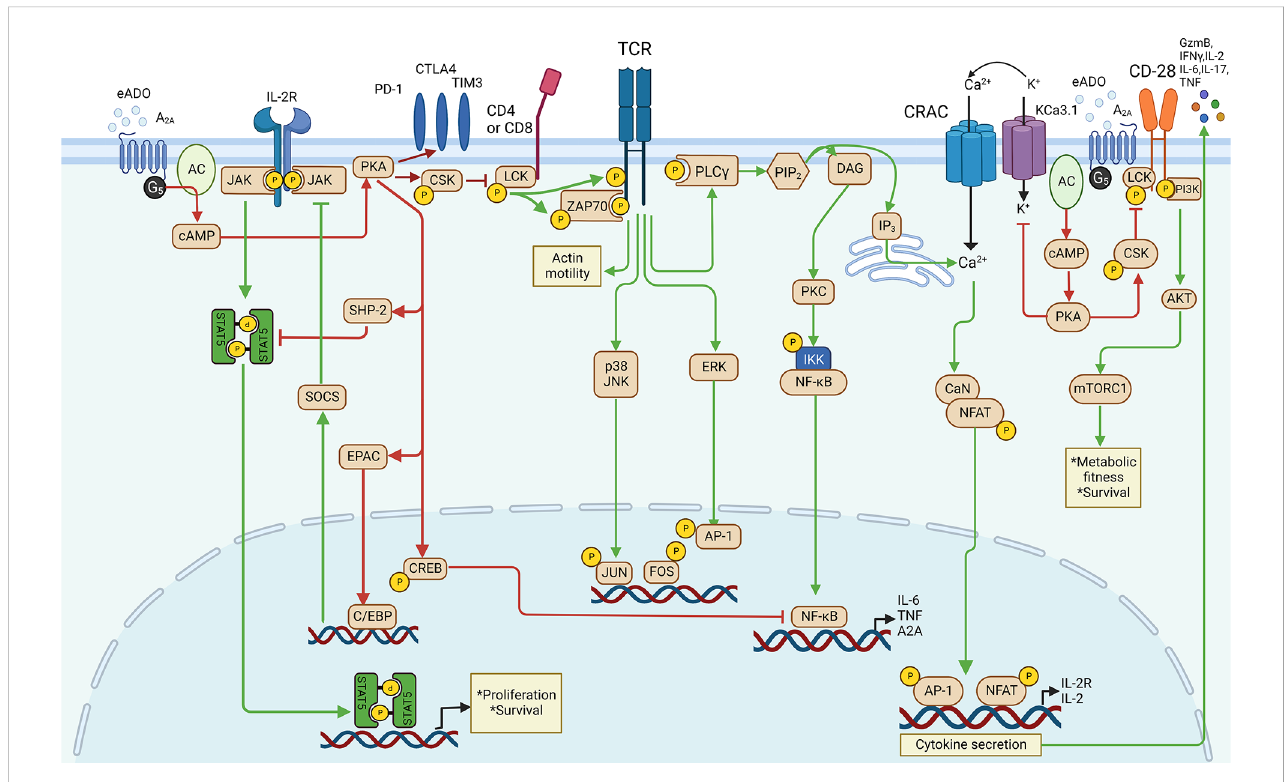
FIGURE 2 eADO/adenosine signaling in T